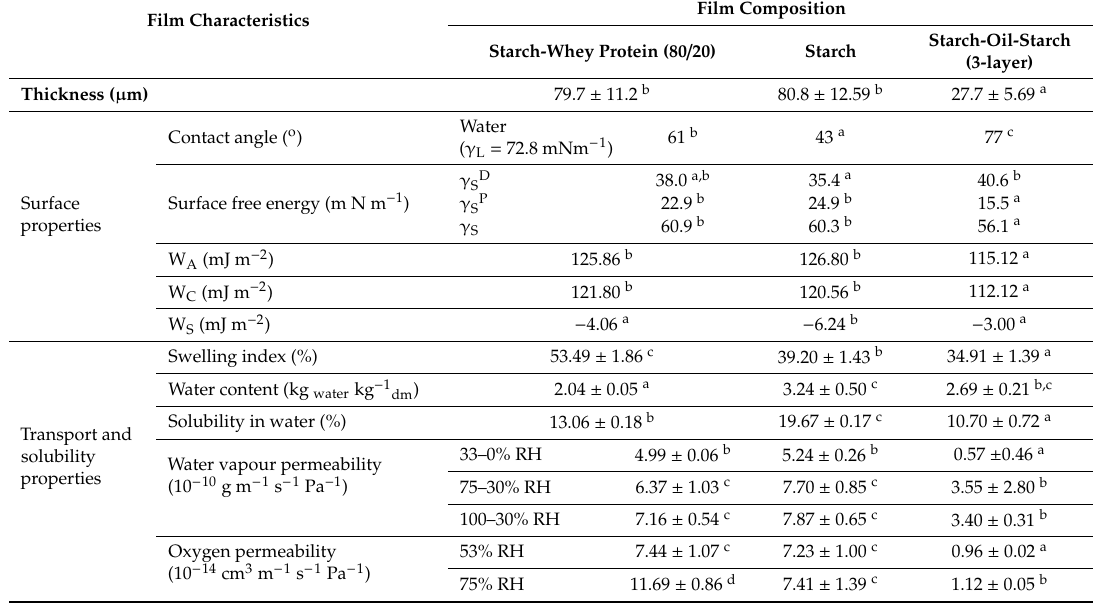
Table 2. Physico-chemical characteristics of films: surface tension of liquids ( γ L ), surface tension of films ( γ S ) and their dispersive ( γ SD ) and polar ( γ SP ) components, adhesion (W A ), cohesion (W C ) and spreading coe ffi cients (W S ), swelling index, water content, solubility in water, water vapour and oxygen permeabilities at 25 ◦